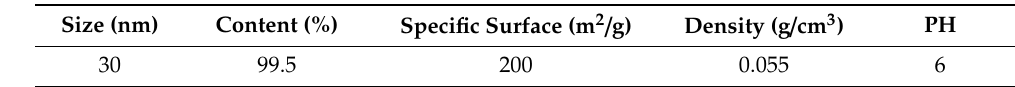
Table 3. Nano-SiO 2 (NS) properties.